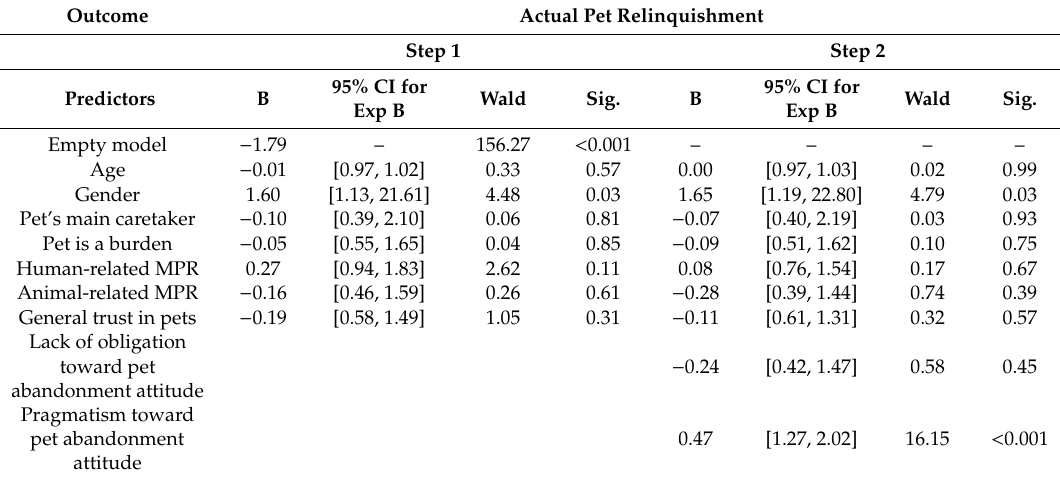
Table 5. Correlates of actual pet relinquishment (unstandardized regression coe ffi cients and associated